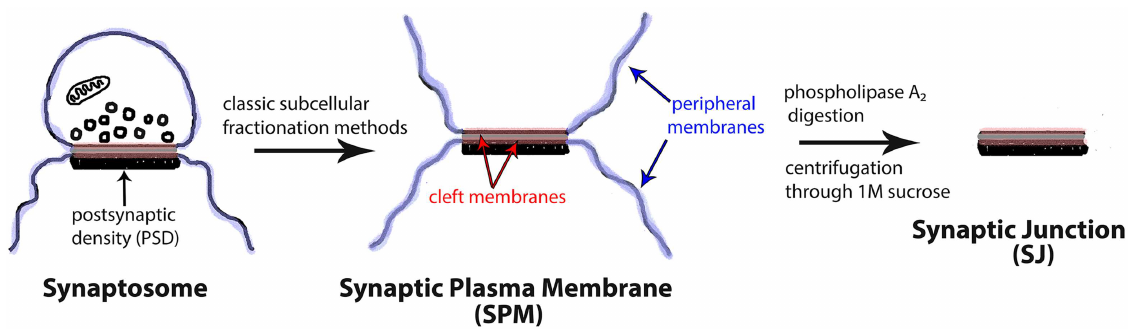
Fig 1. Strategy for the isolation of synaptic junctions. The synapticcleft is highlightedin gray. ‘Cleft membranes’ are definedas the membranes within the synaptic junctionalarea, highlighted in red. Membranes peripheral to the synaptic junctionare referred to as ‘peripheralmembranes’ and are highlighted in blue. Treatment of the SPM fraction with phospholipase A 2 is expectedto promote preferentialremoval of peripheralmembranes as comparedto the relatively occludedcleft membranes.